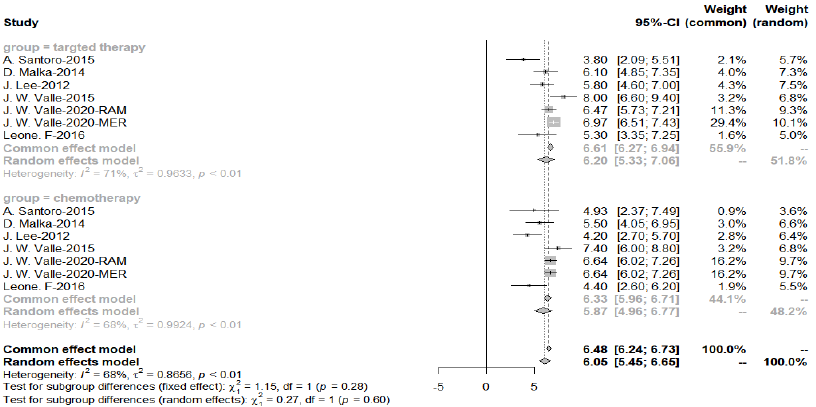
Figure 19. Objective response rate of targeted therapies.